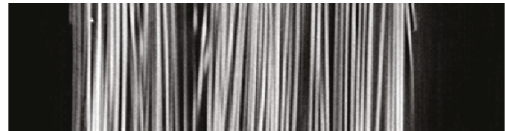
Figure 2: CT scan of a sample component. The tight packing of fibers in the material can be clearly seen.